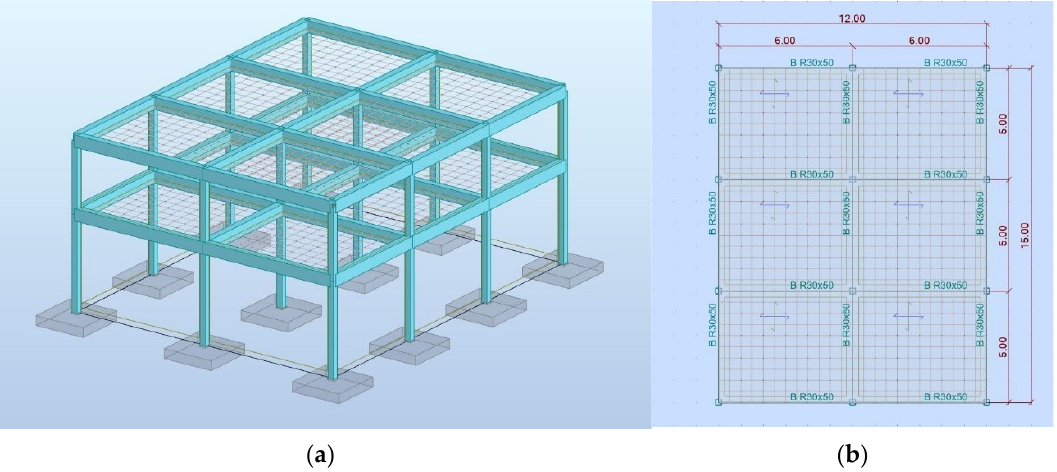
Figure 4. Reinforced concrete structure model under analysis: ( a ) general view; ( b ) view of the reinforced concrete structure (geometric dimensions in m).